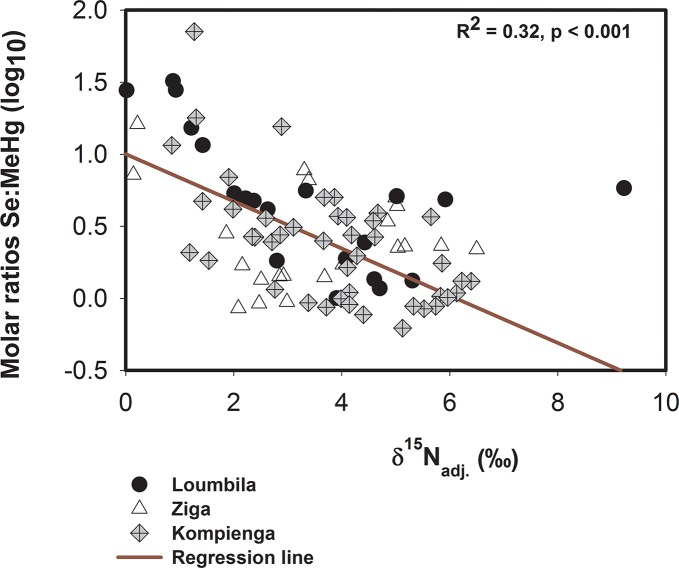
Regression between δ15Nadj and log-transformed Se:MeHg molar ratios for fish of all reservoirs.